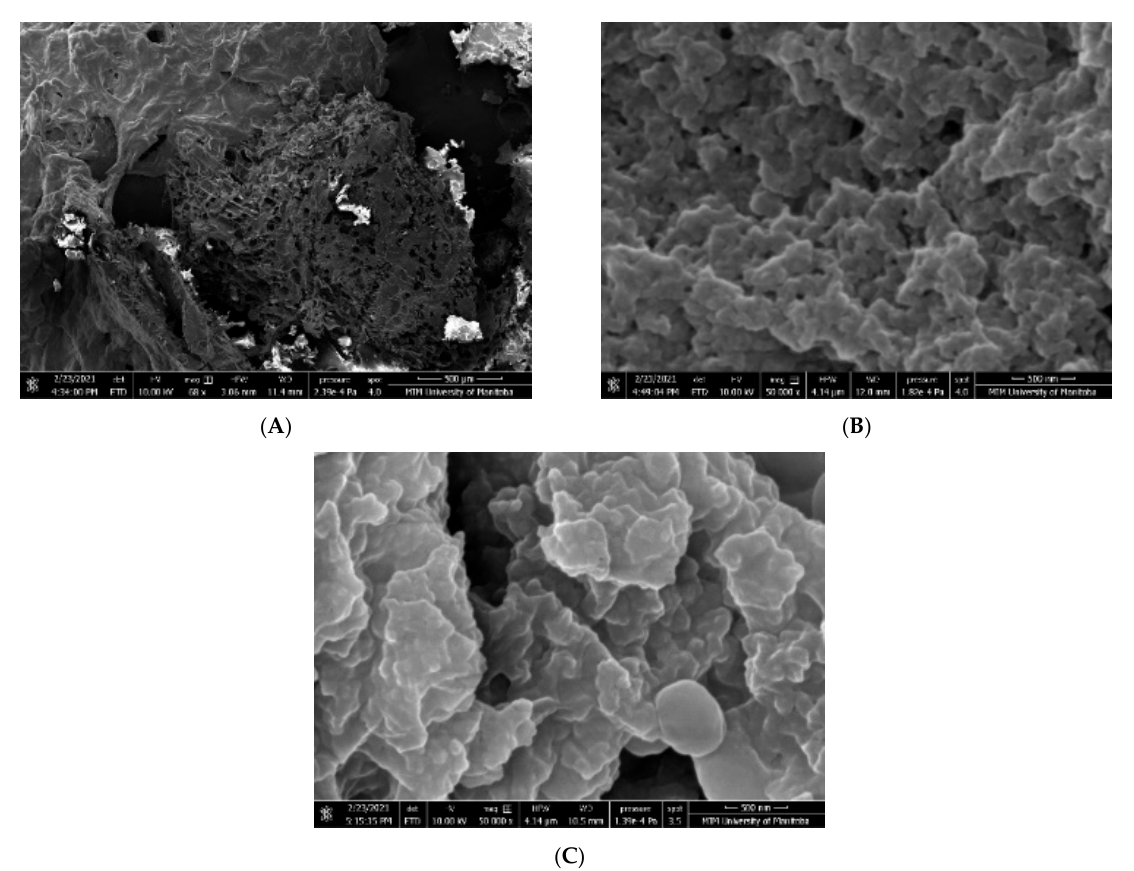
Figure 4. Scanning electron micrographs at 500 µm of: ( A ) isoelectric pH precipitated isolate (ISO); ( B ) membrane isolated proteins from alkaline solution extract (MEM_NaOH); ( C ) membrane isolated proteins from salt solution extract (MEM_NaCl).